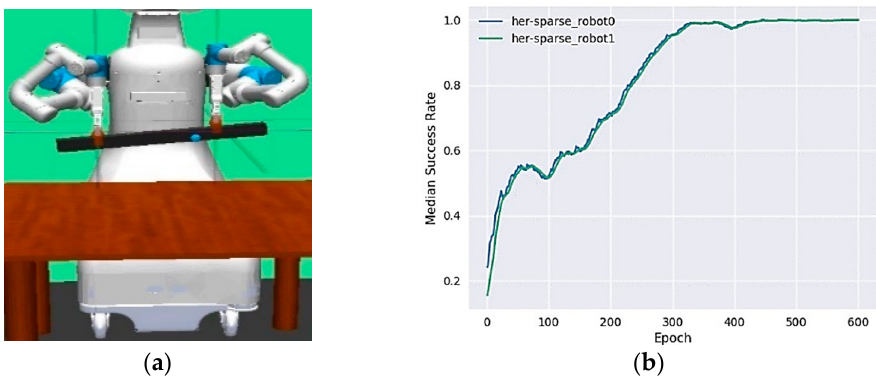
Figure 4. Pick up scene. ( a ) This task is similar to the Push scene, but the target position is in a specific area above the table. The robot needs to hold the block on the target position. ( b ) The learning curve of Pick up scene—the abscissa is the number of training rounds and the ordinate is the average success rate of 10 tests.